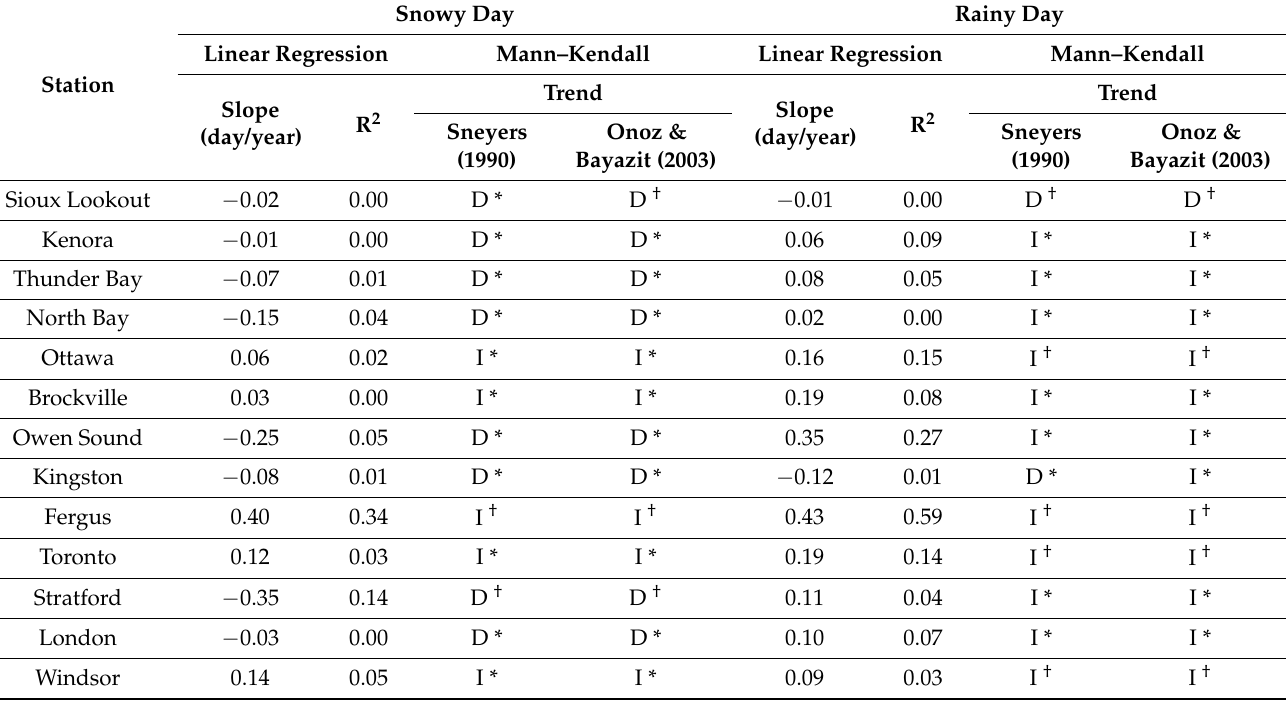
Table 7. Trend analyses of number of snowy days and rainy days during winter. Snowy Day Linear Station